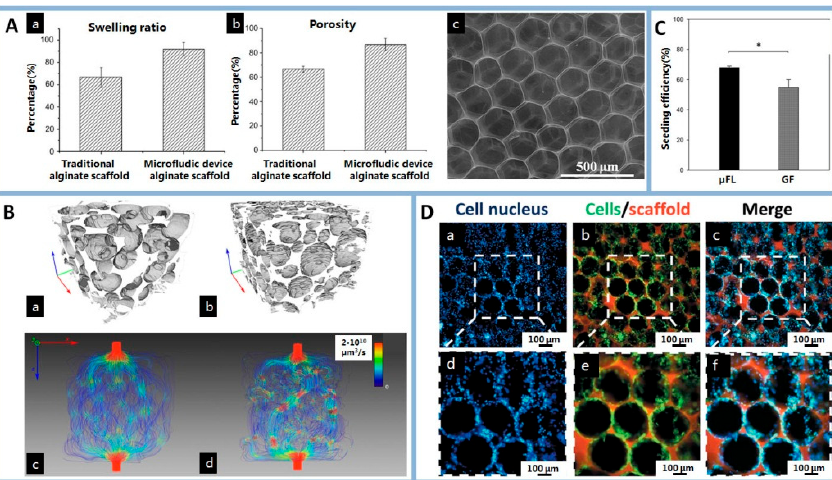
Figure 8. ( A ): (a) swelling ratio and (b) the average porosity of microfluidic alginate scaffold and the traditional alginate scaffold, (c) SEM of microfluidic alginate scaffold. Reprinted from [104] with permission. Copyright 2011 Elsevier. ( B ): 3D reconstructions of μ FL (a) and GF scaffolds (b) from microcomputed tomography ( μ CT) data, volumetric fluid flow through μ FL (c) and GF (d) scaffolds